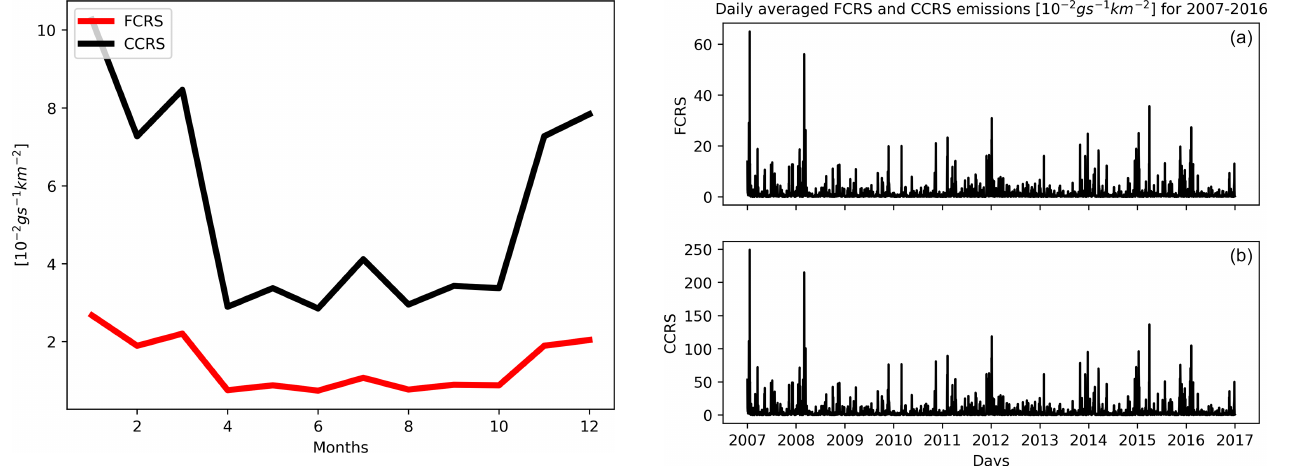
Figure 4. Domain-averaged daily WBD emission fluxes of FCRS (a) and CCRS (b) for 2007–2016 (in 10 − 2 gs − 1 km − 2